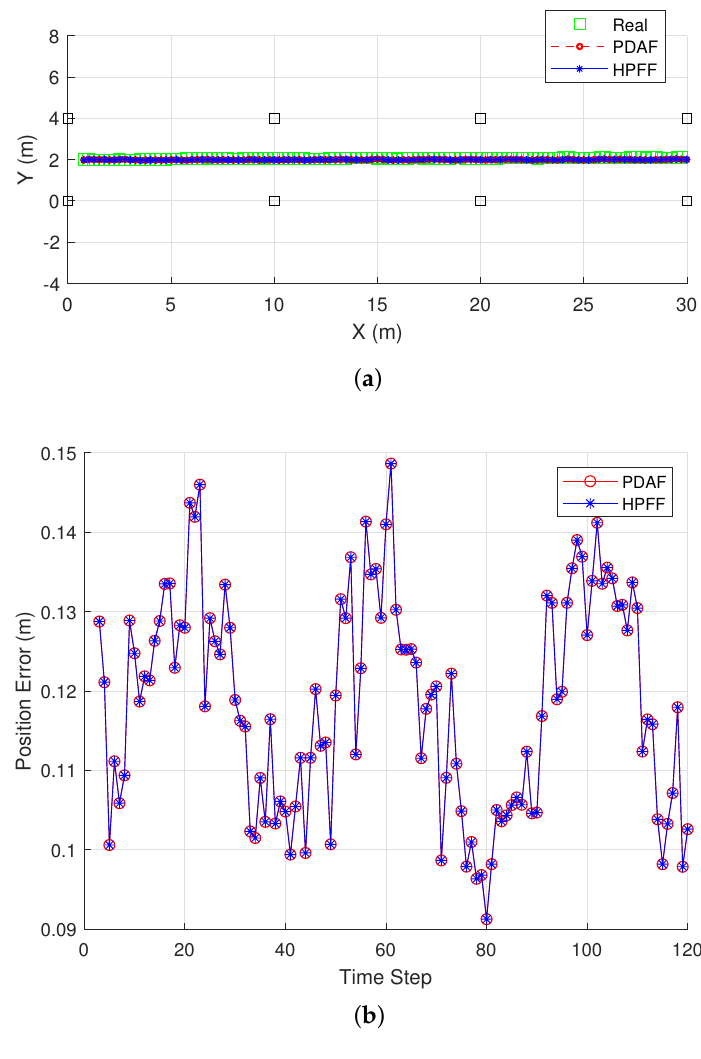
Figure 5. Results of indoor localization using PDAF and HPFF under LOS condition: ( a ) trajectory of mobile node, and ( b ) RMS position